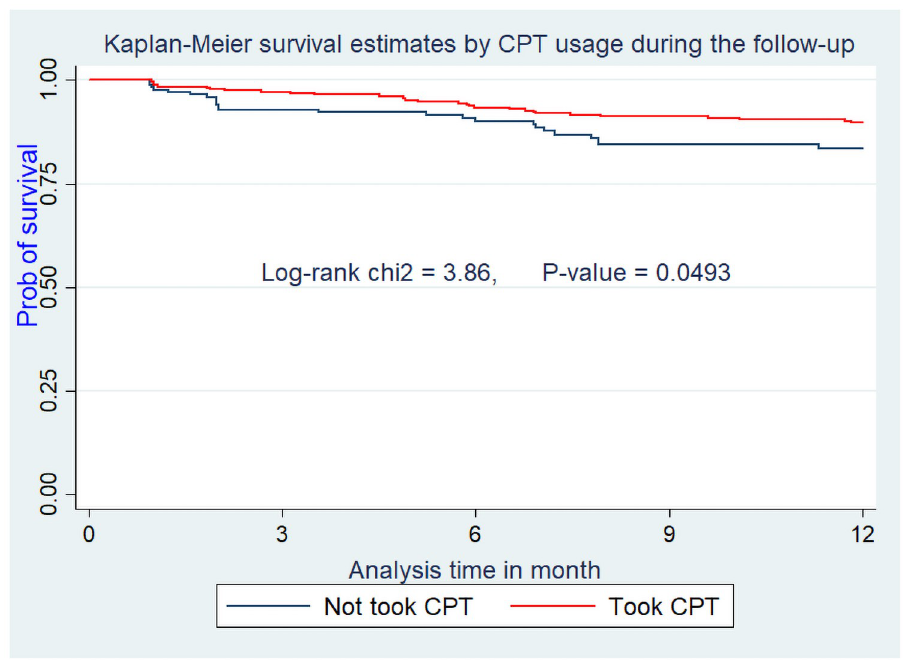
Fig 5. Kaplan Meier survival curve from ART initiation to death within one year stratified by CPT usage among adults on ART at Debre-Markos Referral Hospital from Jan 1, 2014, to Dec 31, 2018.